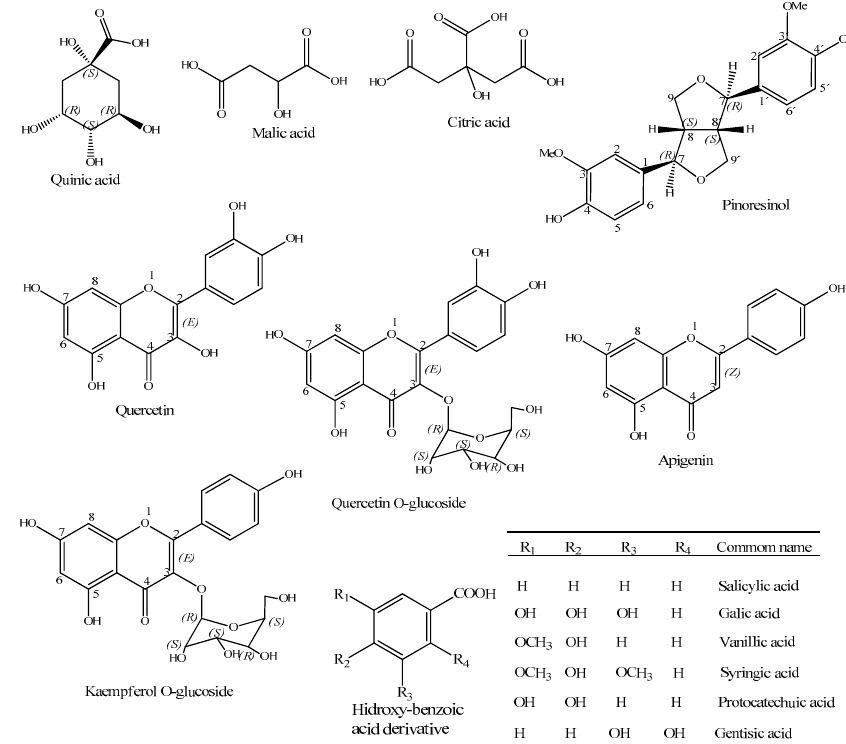
Figure 2. Chemical structures of the compounds identified in the negative mode.